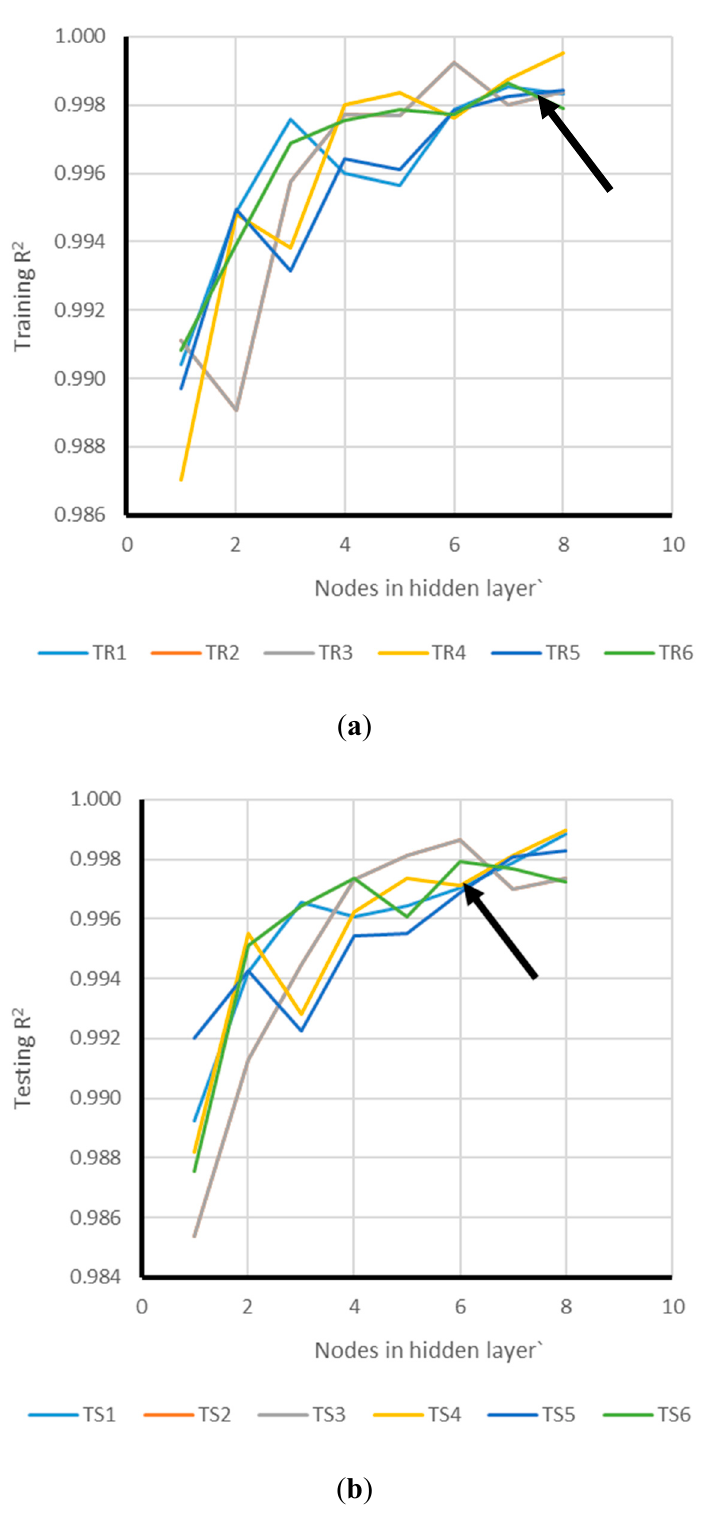
Figure 7. The R 2 sensitivity evaluation of various suggested ANNs on neurons number in each hidden layer. ( a ) R2 performance for the training dataset, ( b ) R2 performance for the testing